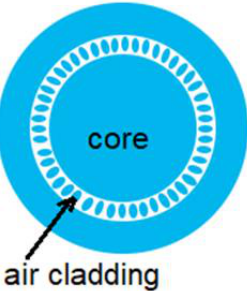
Figure 1. A schematic of a three-channel SDM system, consisting of a center disk and two concentric rings.